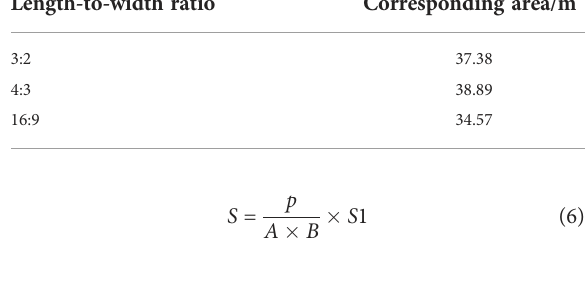
TABLE 1 The aspect ratio of the photo corresponds to the actual area. Length-to-width ratio Corresponding area/m 2